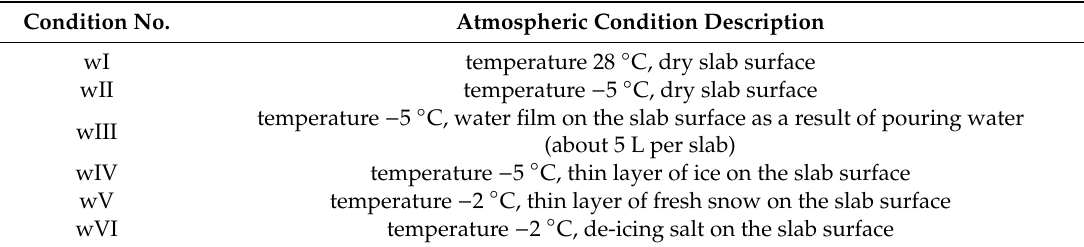
Table 3. Atmospheric conditions during GPR surveys.